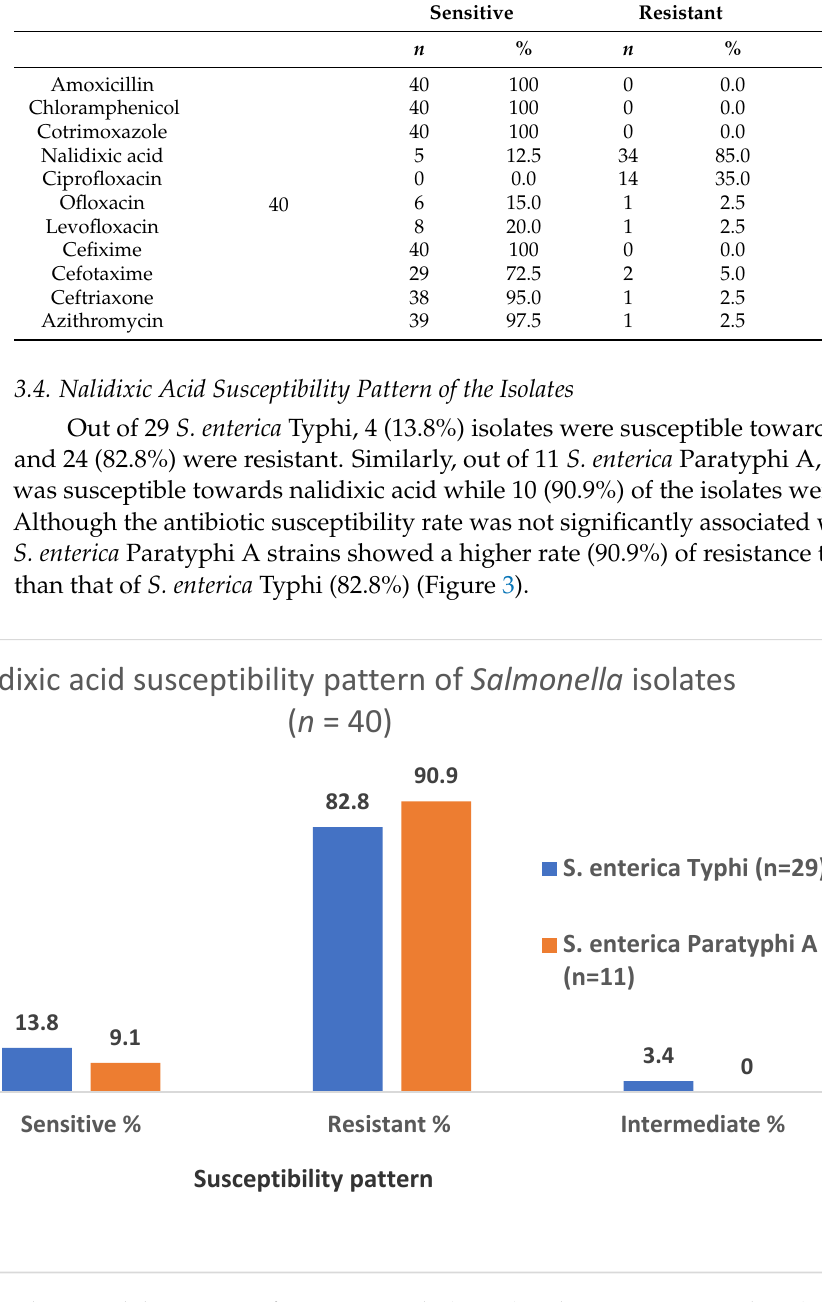
Figure 3. Nalidixic acid susceptibility pattern of S. enterica Typhi ( n = 29) and S. enterica Paratyphi A ( n = 11).